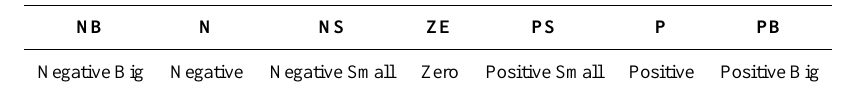
Table 1. Notation for fuzzy sets